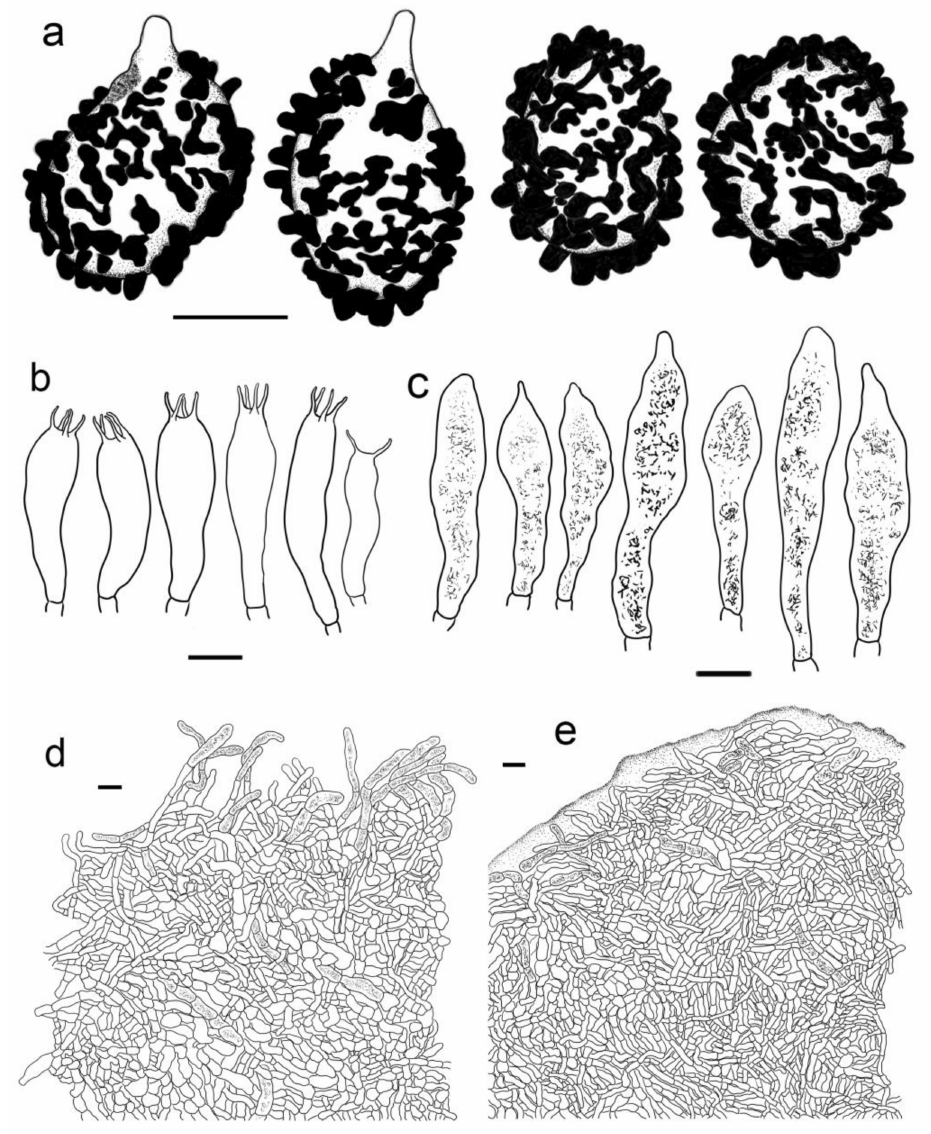
Figure 11. Russula rhodochroa . (HBAU15905, Holotype). ( a ) Basidiospores . ( b ) Basidia . ( c ) Pleurocystidia . ( d ) Suprapellis and partial subpellis in pileus centre. ( e ) Suprapellis and in pileus margin. Bars: ( a ) = 5 µ m, ( b – e ) = 10 µ m. Fungal Names: FN